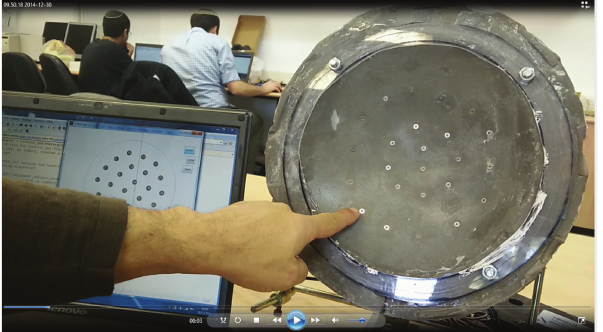
Algorithm 1: A naive algorithm for searching a maximal configu- ration